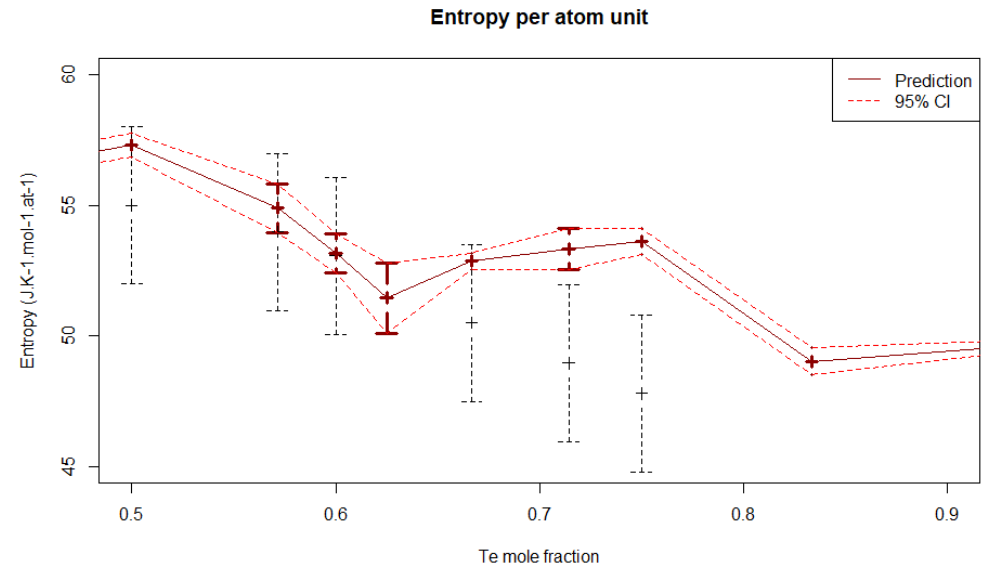
Figure 10. Uncertainty estimation given by the 95% credible interval of the posterior probability distri- bution for the calculated entropies for UTe, U 3 Te 4 , U 2 Te 3 , UTe 2 , U 2 Te 5 , and UTe 3 . The experimental error bars are in doted black lines. The propagated uncertainties (95% credible interval) for each computed quantity are in bold red